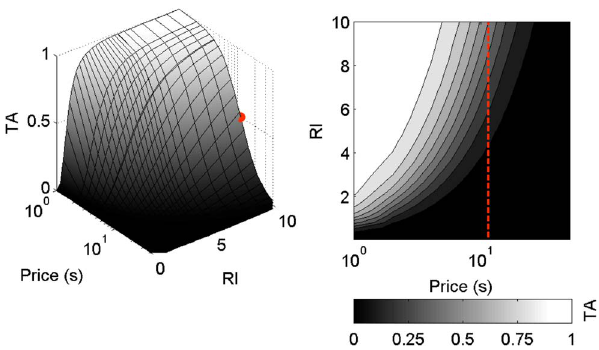
Figure 5. Mountain model. Left panel: 3-dimensional relationship; right panel: contours of equal time allocation, as a function of reward intensity and price predicted by the mountain model using the generalised matching law. Red lines in right panel show P L : the price at which TA ~ 0 : 5 for a maximal reward intensity (red dot in left panel). a ~ 2 : 65, P L ~ 11 : 4 s . The TA contours smoothly increase with reward intensity and smoothly decrease with price.